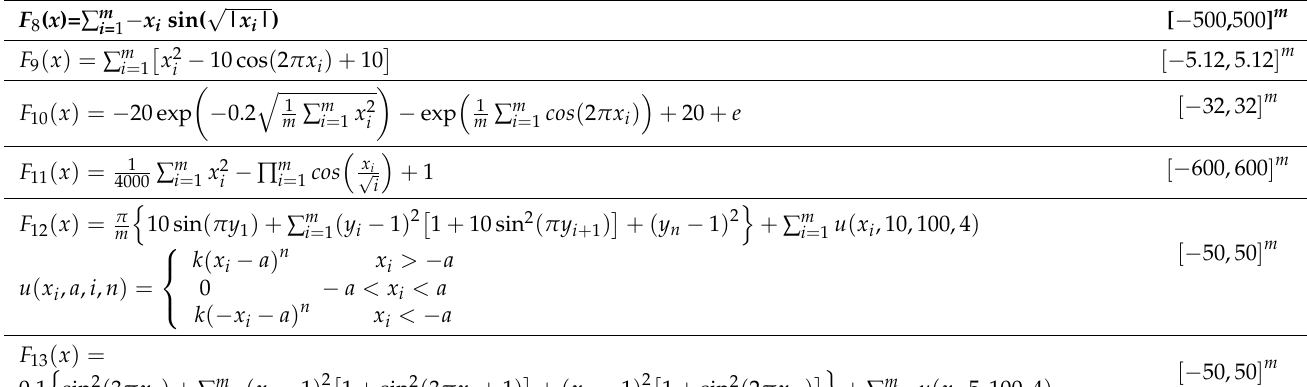
Table A2. Multimodal test